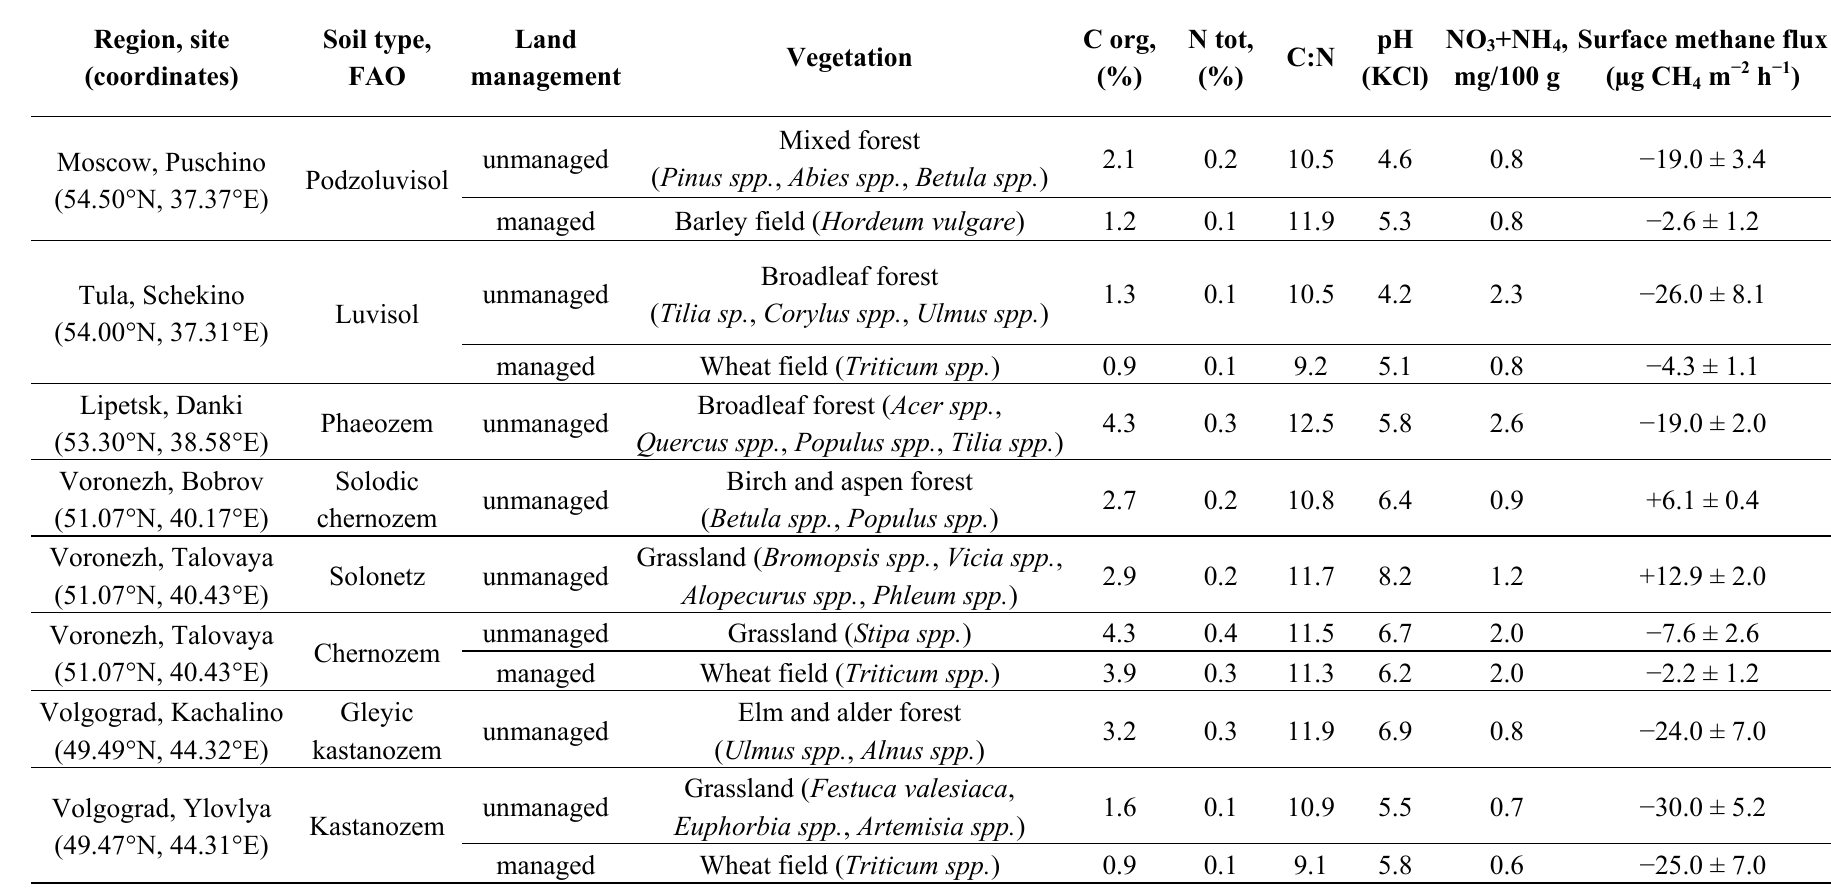
Table 1. Description of soil sampling sites and selected soil